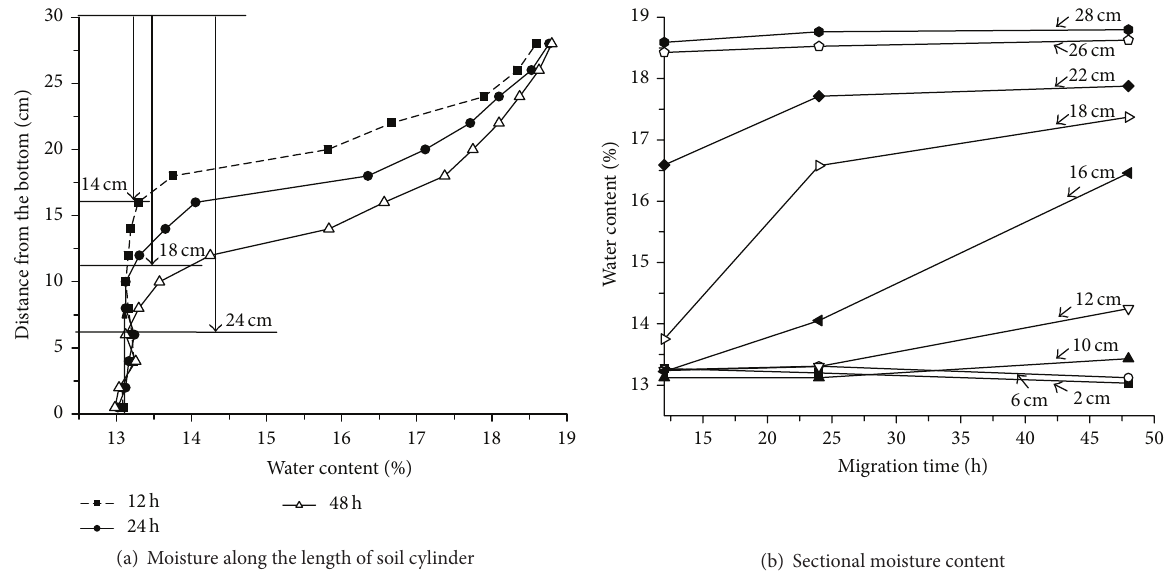
Figure 5: Distribution of water content in the rainfall simulation